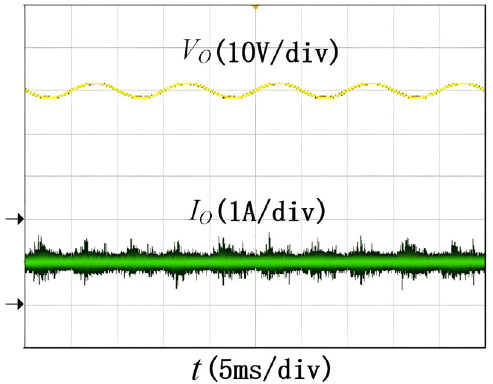
Figure 11. Waveforms of filter capacitor voltage V O and LED current I O.